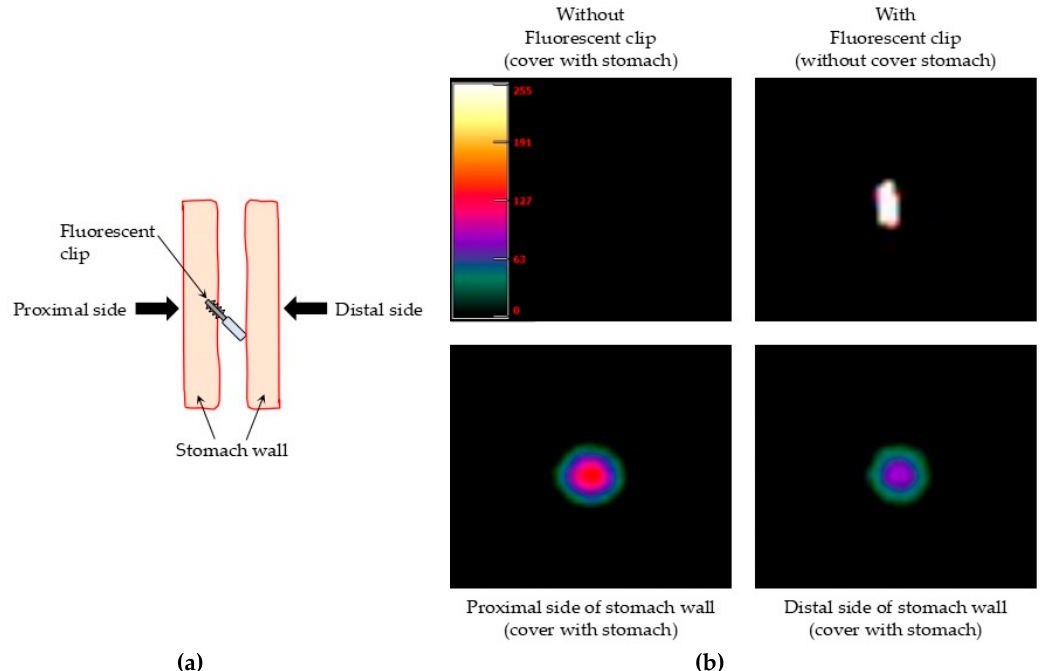
Figure 6. Ex vivo detection of the near-infrared fluorescent clips fixed in human stomach. ( a ) Schematic representation of the detection method of the fluorescent clips fixed in the human stomach. ( b ) A stronger fluorescent image of the clip from the proximal side of the stomach wall than from the distal side was observed.